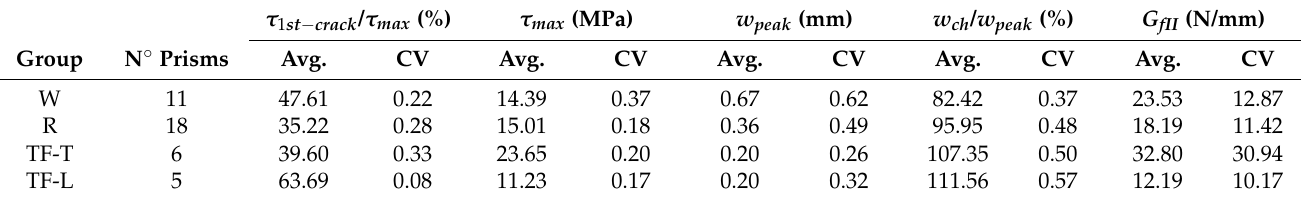
Table 4. Mechanical